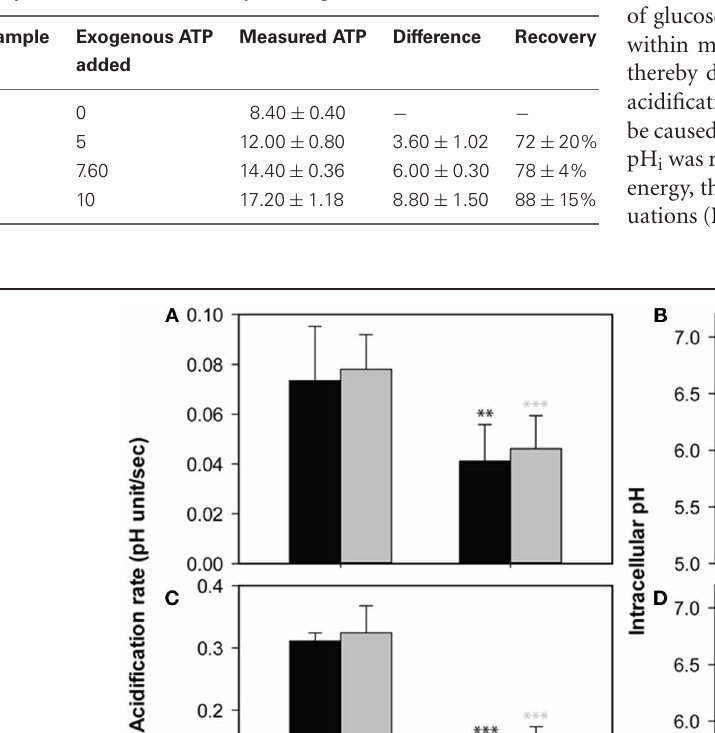
absence (gray) of glucose. Data presented are the average of three independent cultivations and error bars represent standard deviations. An asterisk indicates significance of the difference between control and pre-adapted cultures, or between conditions indicated with a marker (two-tailed t -test; ∗ p < 0 . 05; ∗∗ p < 0 . 01; ∗∗∗ p < 0 .